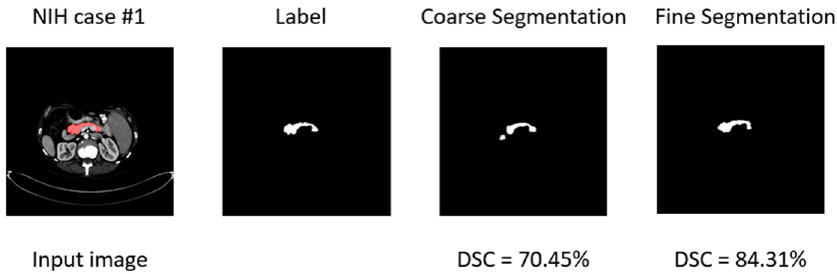
Fig 7. An example of the segmentation results. Compared with the coarse segmentation, fine segmentation result has been improved from 70.45% to 84.31%. However, we can observe that we cannot predict the boundary of the pancreas very